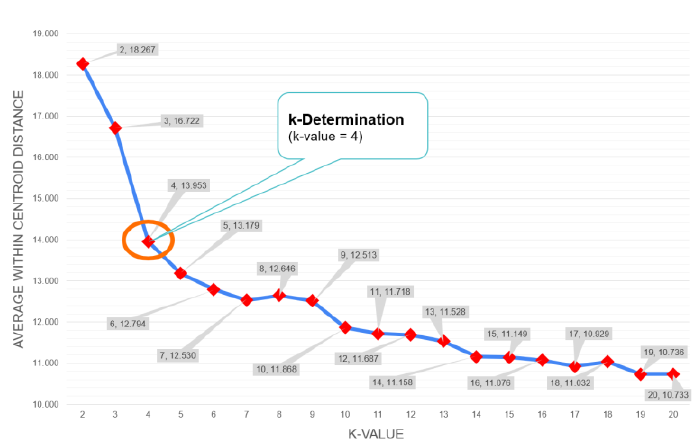
Fig. 6. The Appropriate